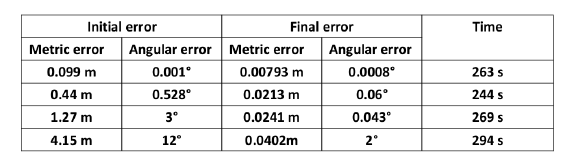
Table 1. Result of indoor/indoor registration